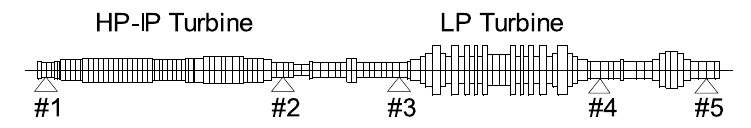
Fig. 16. Finite Element Model of the shaft-train composed of the HP-IP and the LP steam